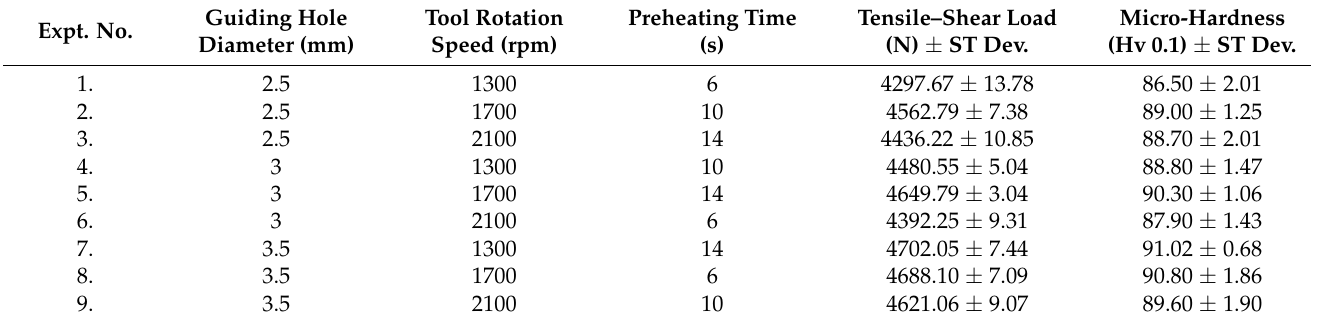
Table 2. Process parameters and experimental results.